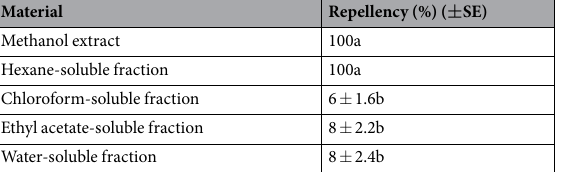
Table 1. Repellency of fractions obtained from the hydrolyzable solvent of the methanol extract of Cyperus rotundus rhizome against male Blattella germanica using a filter-paper choice assay at 244.6 μ g cm − 2 . Means within a column followed by the same letter are not significantly different ( P = 0.05, Bonferroni method).